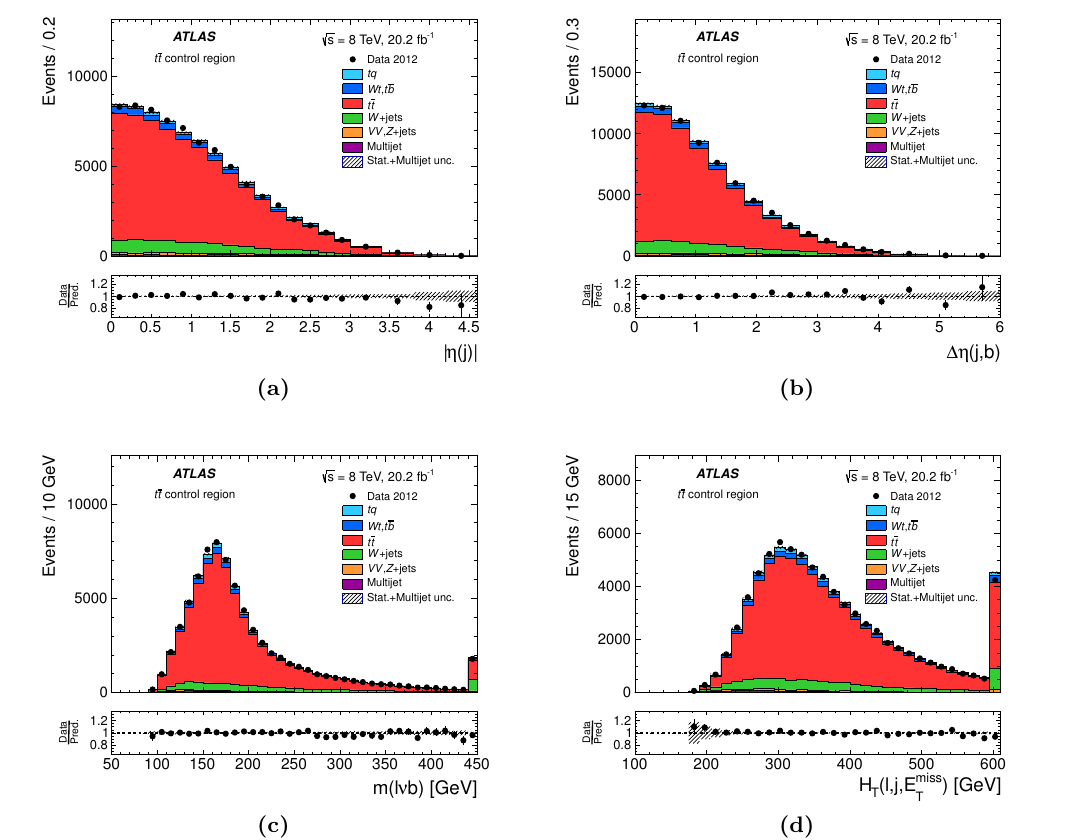
Figure 4. Distributions of the selection variables in the t (cid:22) t control region: (a) jet, (b) separation in (cid:17) between the untagged and b -tagged jets, (c) reconstructed top-quark mass, and (d) scalar sum of the p T of the lepton, the p T of the jets and E miss